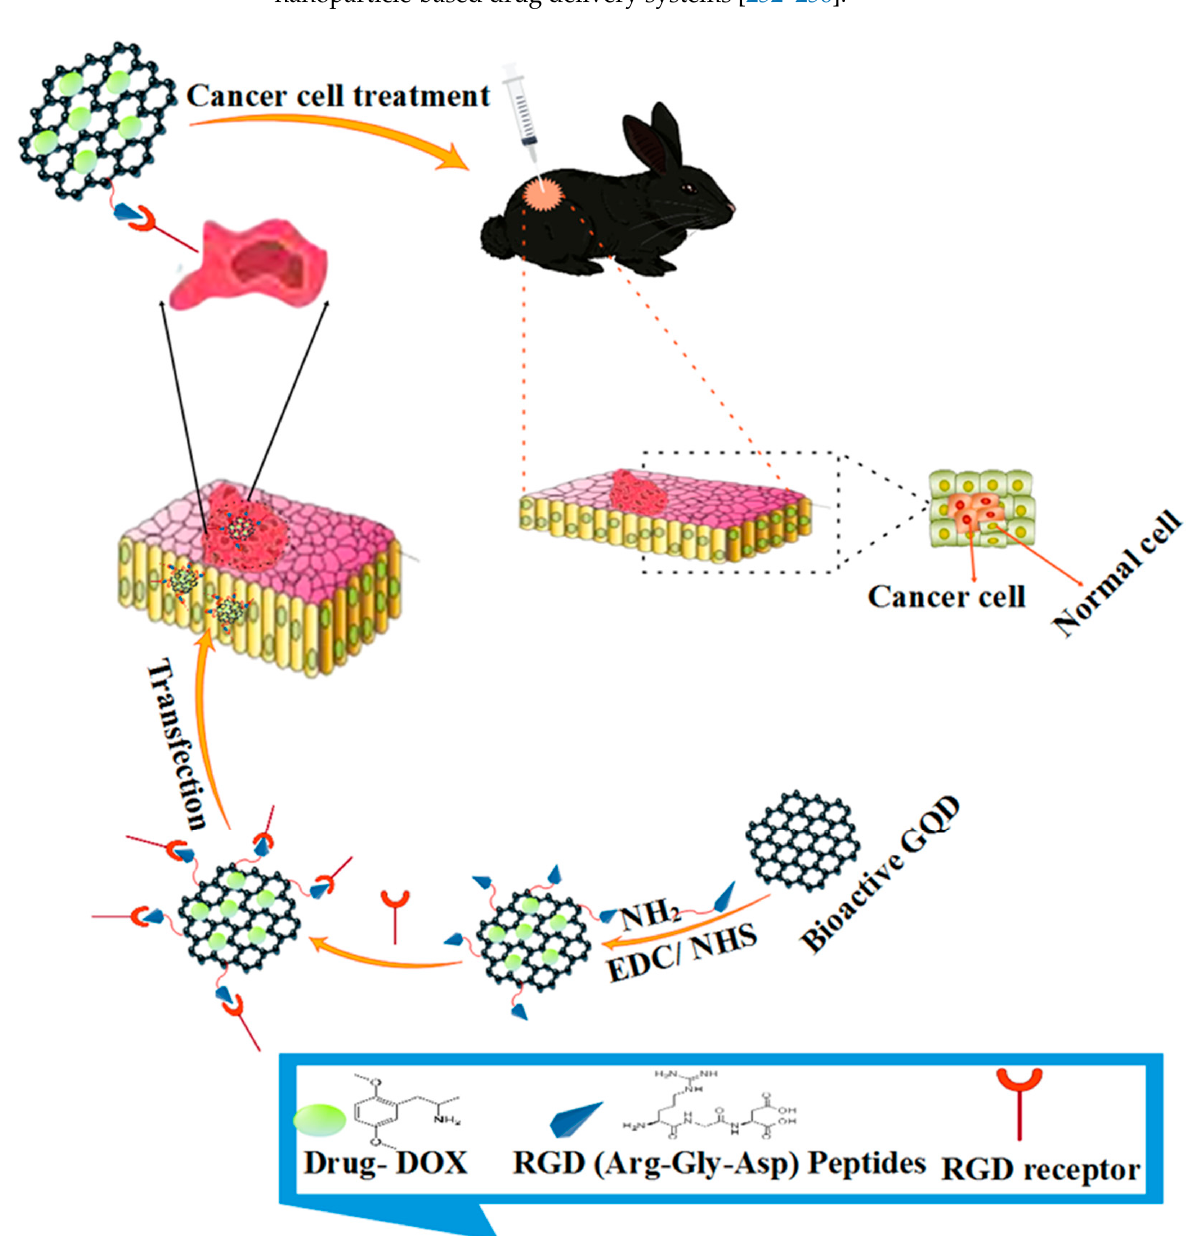
Figure 7. Treatment of cancer cells with drug delivery method based on bioactive